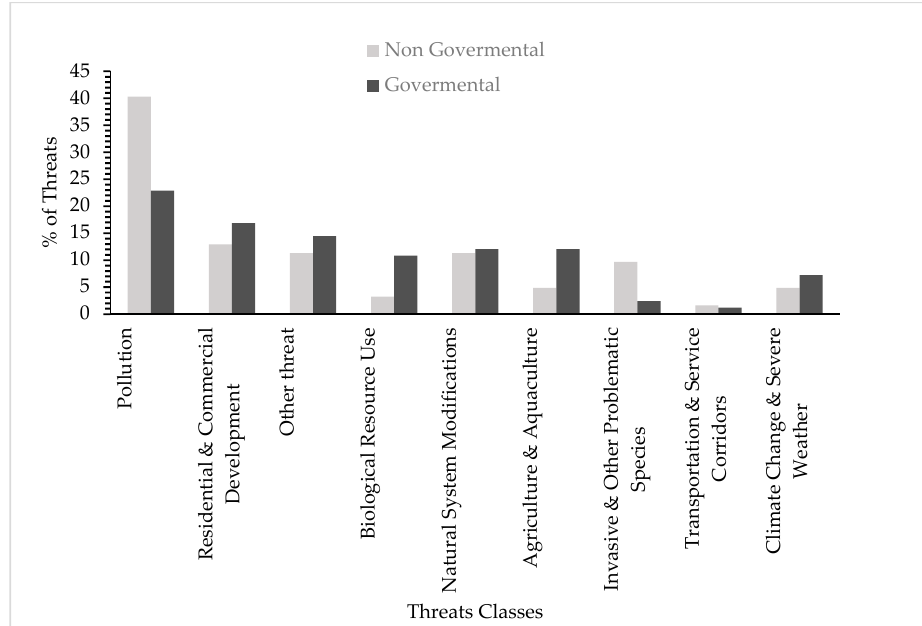
Figure 2. Classification of the major threats in the Gediz Delta based on the IUCN threats classification system using a systematic literature review (n = 233 sources).